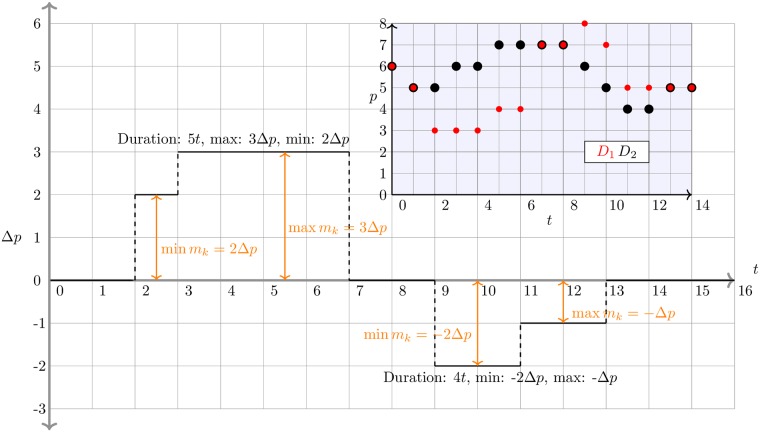
Diagram of two dislocation segments (DS).The inset plot shows the time series of best quotes that generate the DSs. Where the time series diverge from the same value, a DS occurs. We have deliberately not placed units on t, Δp, and p to indicate that DSs can occur in any market in which there are differing information feeds, not just in the NMS, though we do assume that these quantities are quantized. In the case of the NMS, we take t in units of μs and Δp in units of $0.01. For the sake of simplicity this figure only displays one side of a hypothetical book. Marker size in the inset plot is used only for visual distinction.